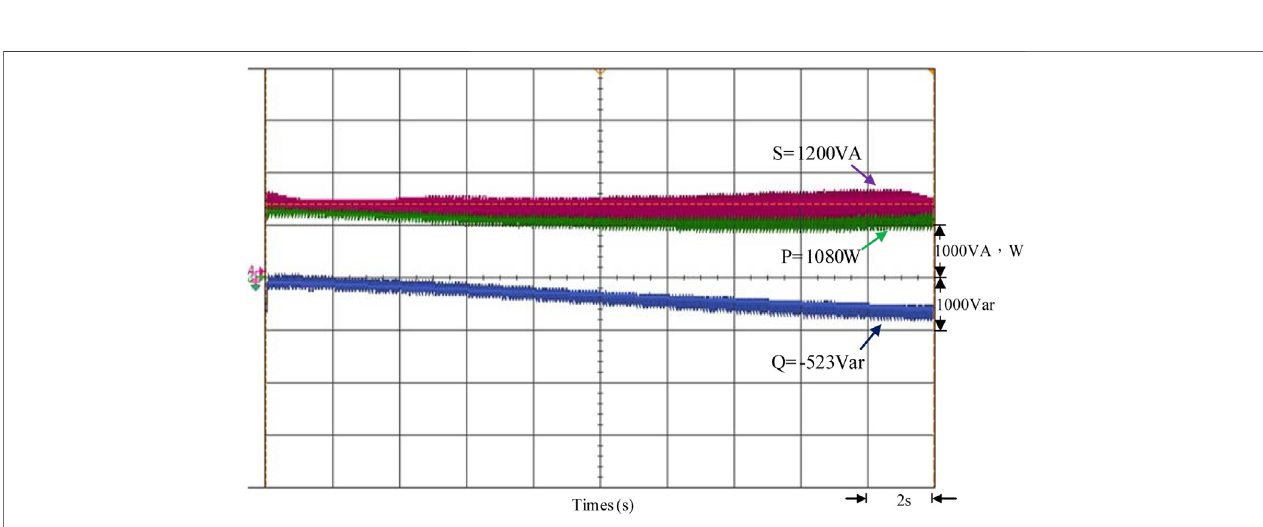
FIGURE 20 | The measured output power regulation of the smart inverter when the grid voltage per unit value is between 0.97 and 1.0 p.u.